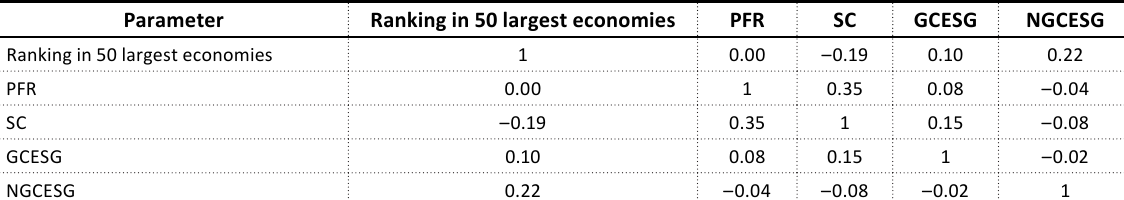
Table D3. Correlation analysis of ESG disclosure regulation and overall competitiveness of the countries: case of developing and emerging